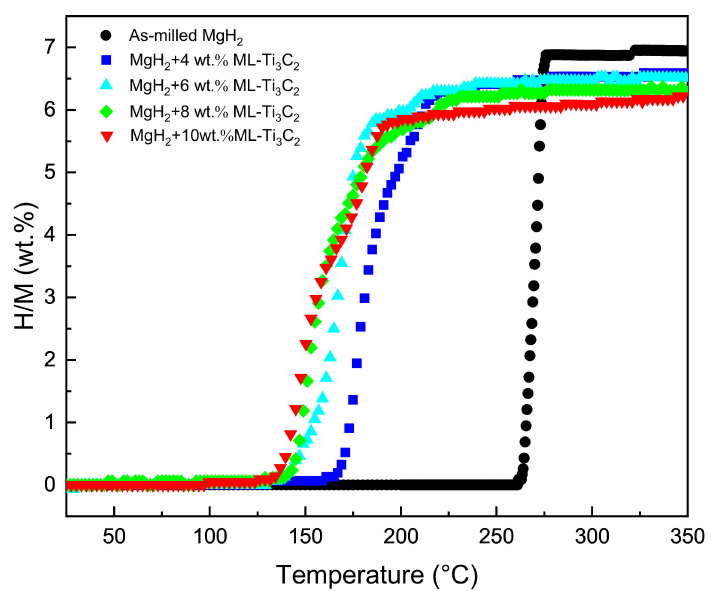
Figure 2. Hydrogen desorption performances of MgH 2 + x wt.% ML-Ti 3 C 2 ( x = 0, 4, 6, 8,